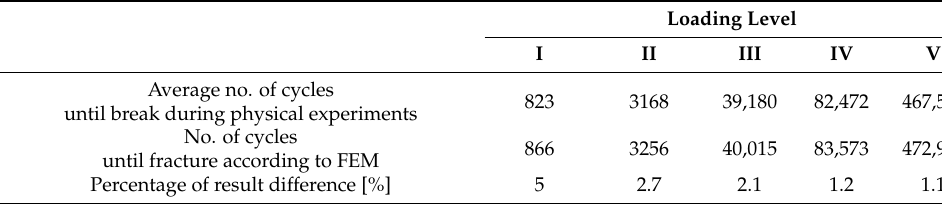
Table 3. Results of comparative analysis of experimental and FEM